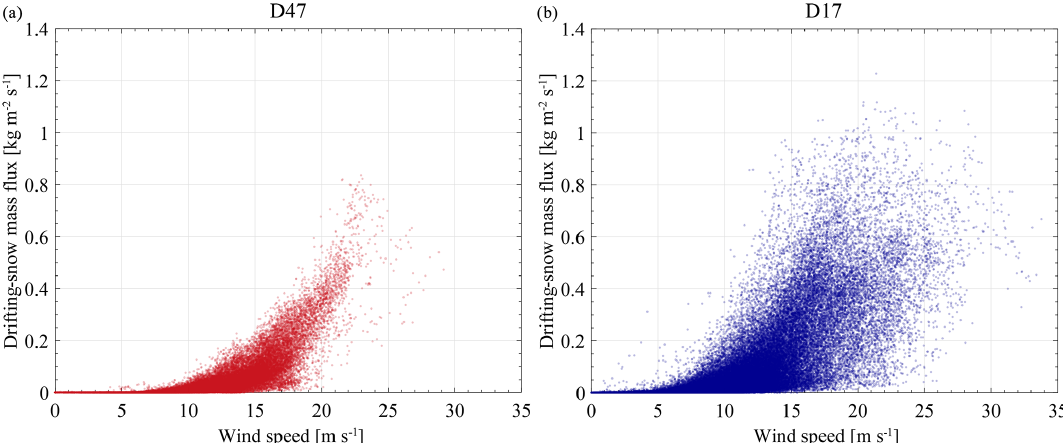
Figure 5. Drifting-snow mass flux against 2m wind speed recorded at D47 (a) and D17 (b) . Only periods for which two 2G-FlowCapt™ sensors are installed and/or the lower sensor is not entirely covered with snow (i.e. h 1 > 0 . 1m) are considered.